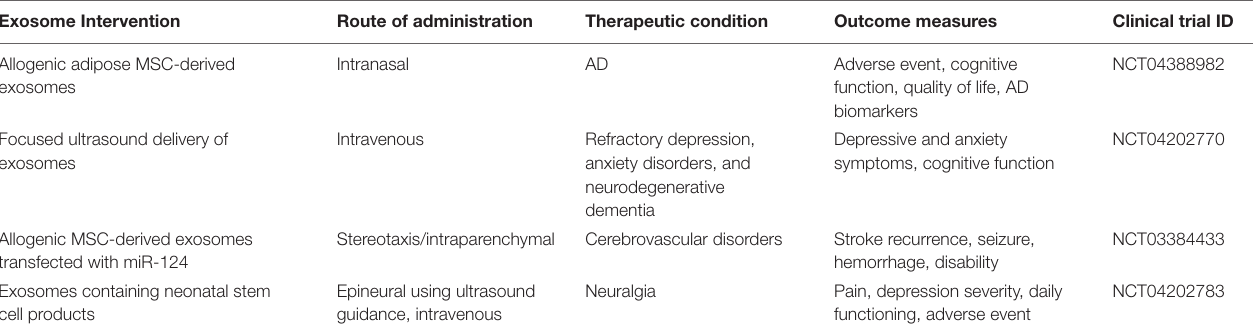
Exosome Intervention Route of administration Therapeutic condition Outcome measures Clinical trial